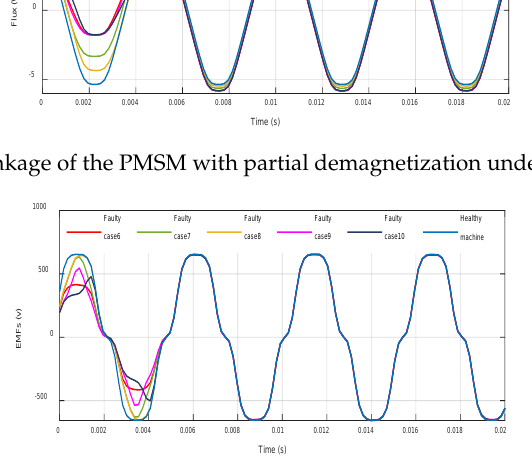
Figure 20. EMFs of the PMSM with partial demagnetization under different cases.